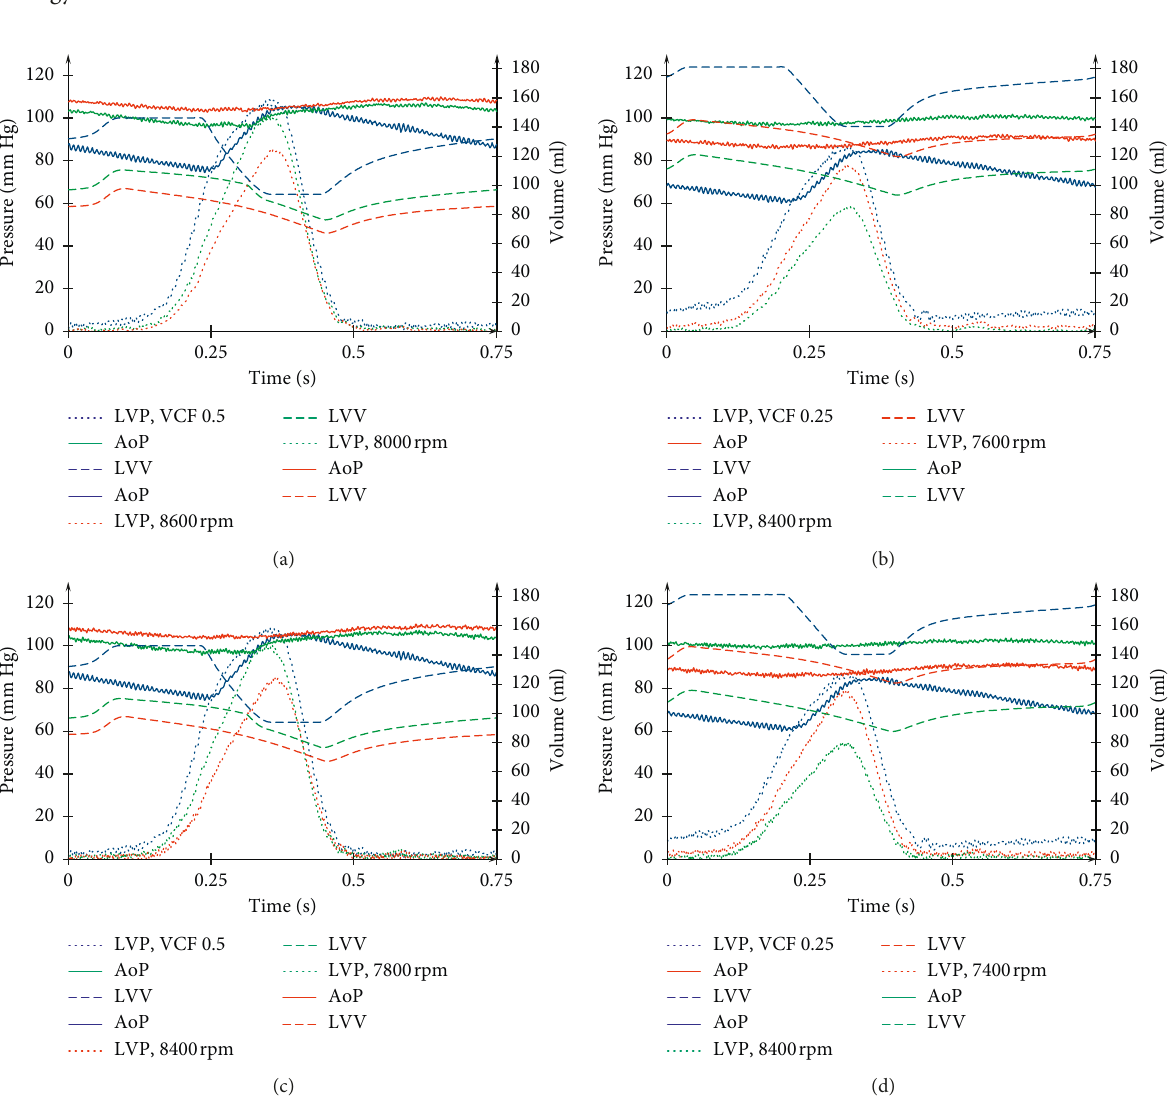
Figure 9: Time courses of the left ventricular (LV) pressure, the volume, and the aortic pressure for moderate and congestive heart failure states simulated with the HAMC at the pump speeds of aortic valve closure (red) and total work attainment of a normal LV stroke work level (green): (a) and (b) during Sputnik 1 LVAD support; (c) and (d) during Sputnik 2 LVAD support. Blue lines represent time courses of condition characteristics simulated without support. Dot lines demonstrate the left ventricle pressure, single lines demonstrate the aortic pressure, and dash lines represent the left ventricle